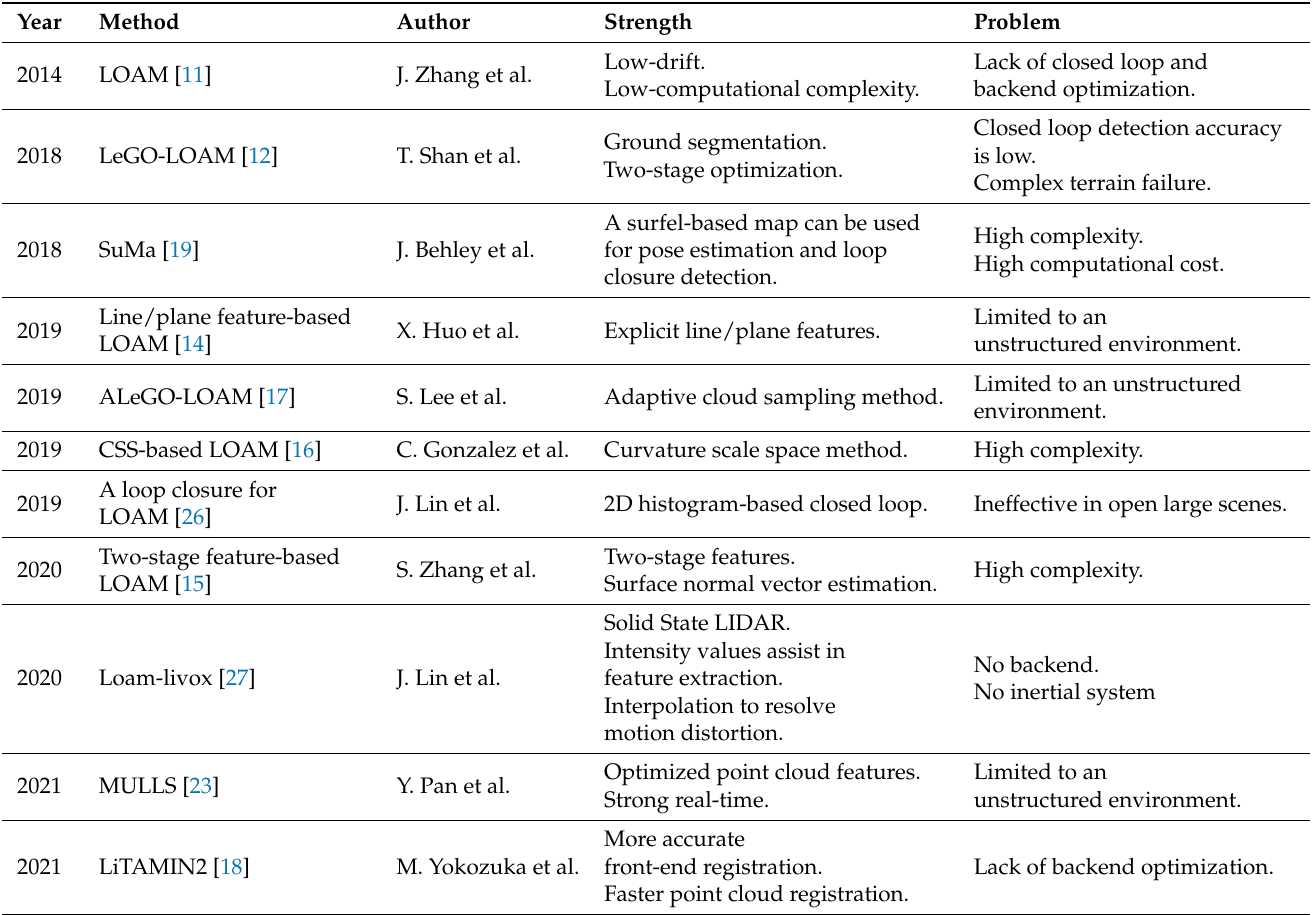
Table 2. LI loosely coupled